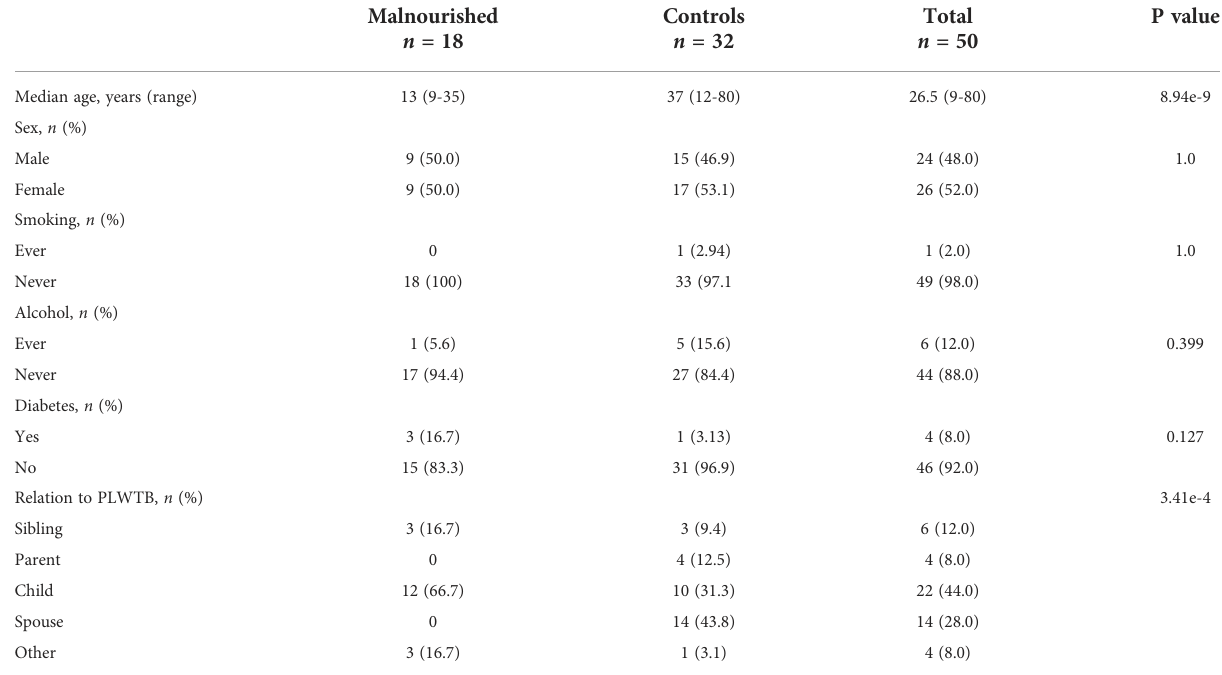
Table depicting demographic characteristics of HHCs with LTBI. PLWTB, person living with TB. P-values were calculated by a Welch ’ s t-test for ages between malnourished individuals and controls, and Fisher ’ s exact test for sex, smoking, alcohol, diabetes, and relation to